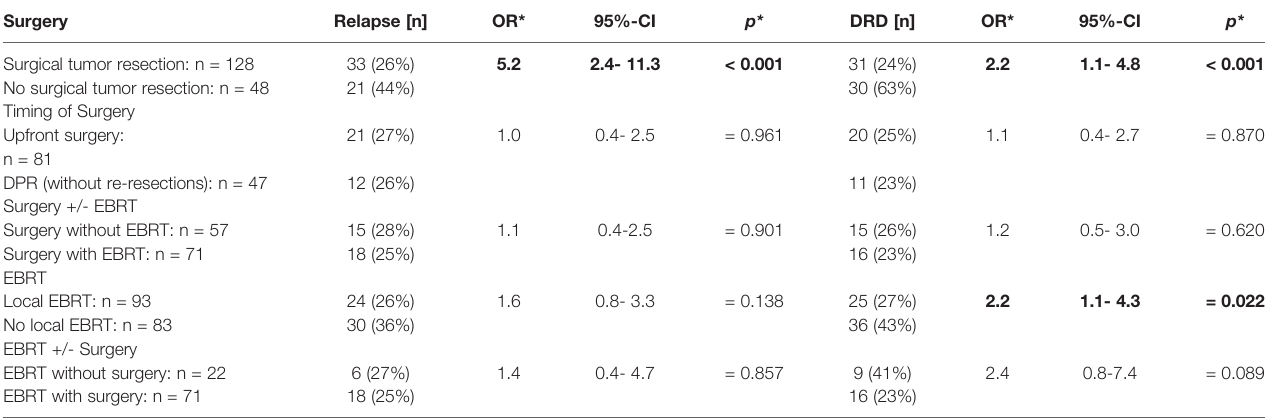
TABLE 3 | Impact of local therapy on rate of relapse and